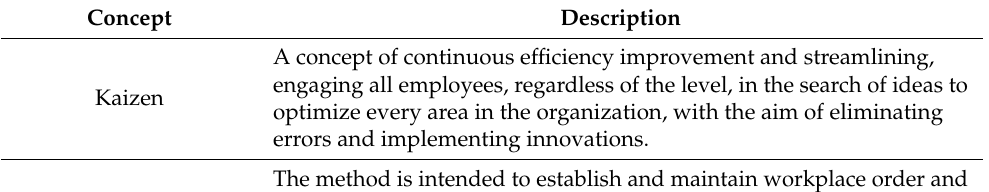
Table 1. Selected energy enterprise management